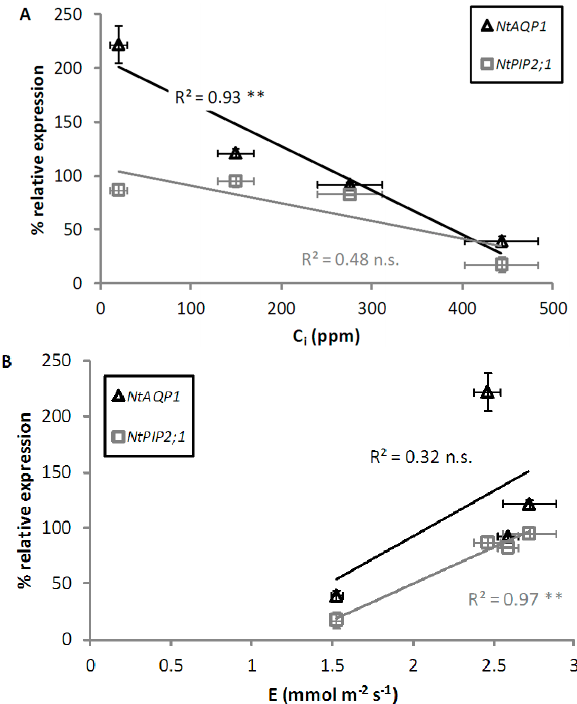
Figure 3. NtAQP1 and NtPIP2;1 transcript levels were plotted respectively vs. ( A ) leaf substomatal CO 2 concentration (C i ) and ( B ) transpiration rate (E). NtAQP1 : black empty triangles; NtPIP2;1 : grey empty squares (means ± SE, n = 3). Asterisks mark significance of regression (** p < 0.01, n.s., not significant).